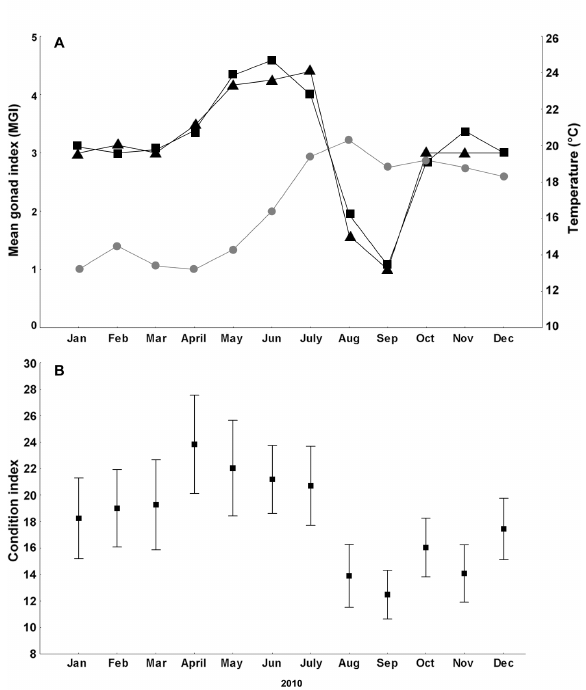
F ig . 6. – A, mean monthly gonad index values of males (squares), females (triangles) and seawater temperature (circles). B, mean monthly condition index and corresponding standard deviation for Glycymeris